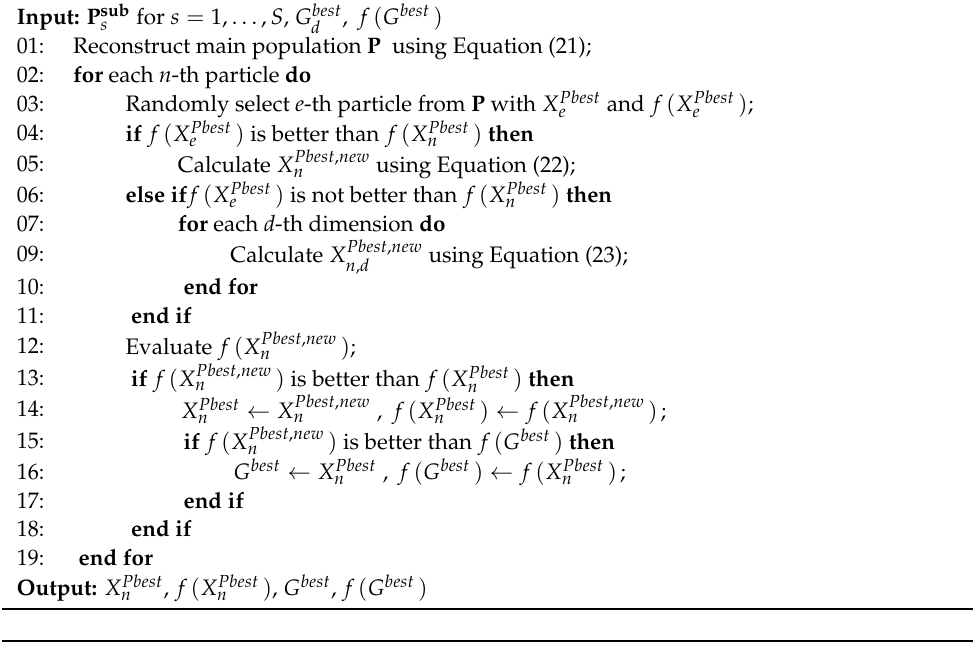
Algorithm 6. Pseudocode of secondary learning phase for MSPSOTLP